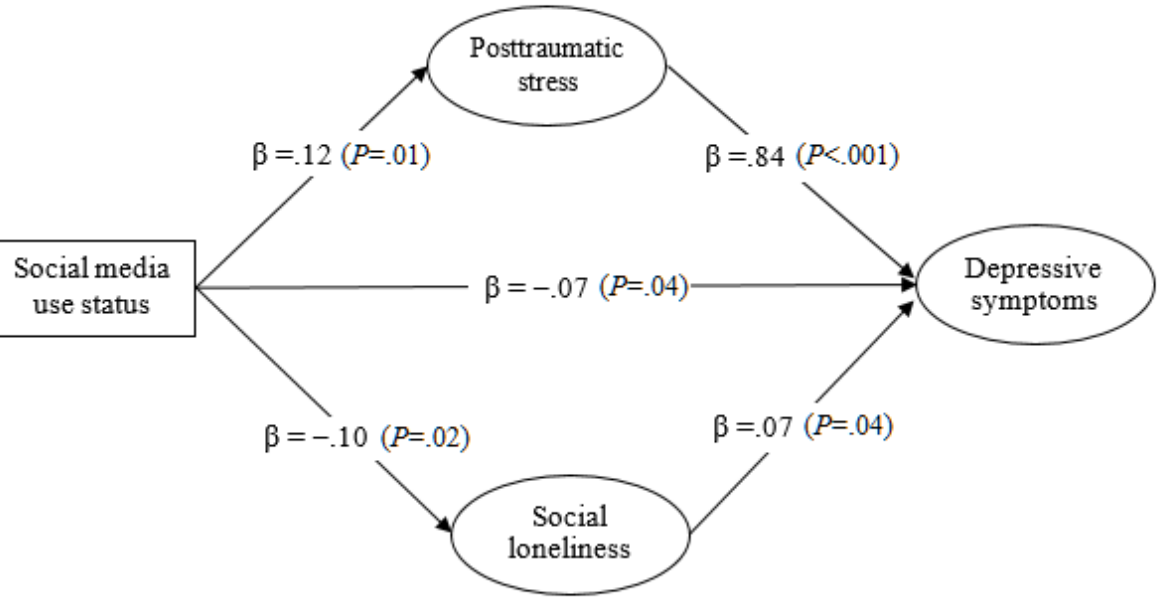
Figure 2. The proposed mediation model of depressive symptoms with standardized regression coefficients ( β ) among older adults in Hong Kong during the COVID-19 pandemic (n=684).